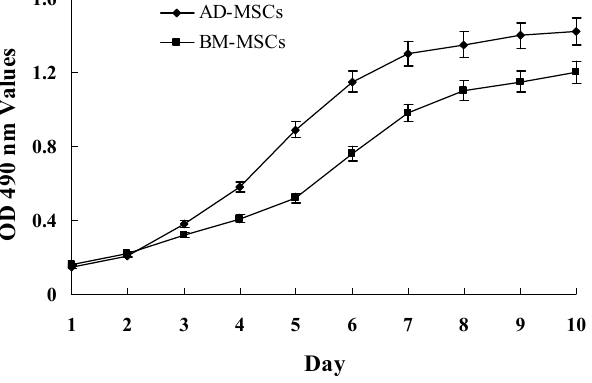
Figure 2. Growth curves of AD-MSCs and BM-MSCs. MSCs were plated at initial density of 2000 cells per cm 2 and the absorption values were detected over 10 days. Each point on growth curve represents absorption value mean. n = 7.